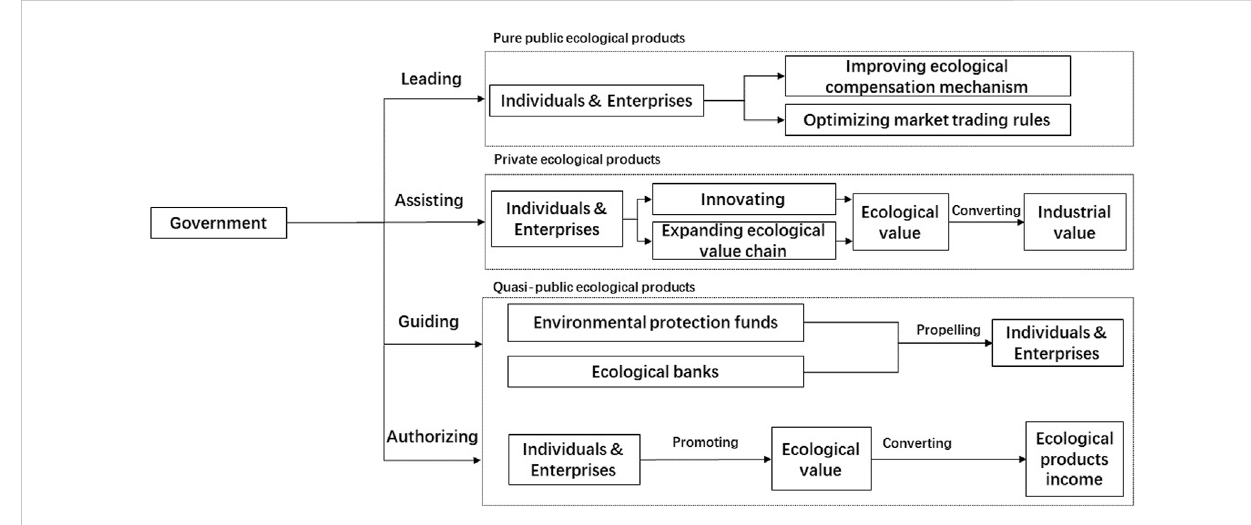
FIGURE 5 Framework of ecosystem service value